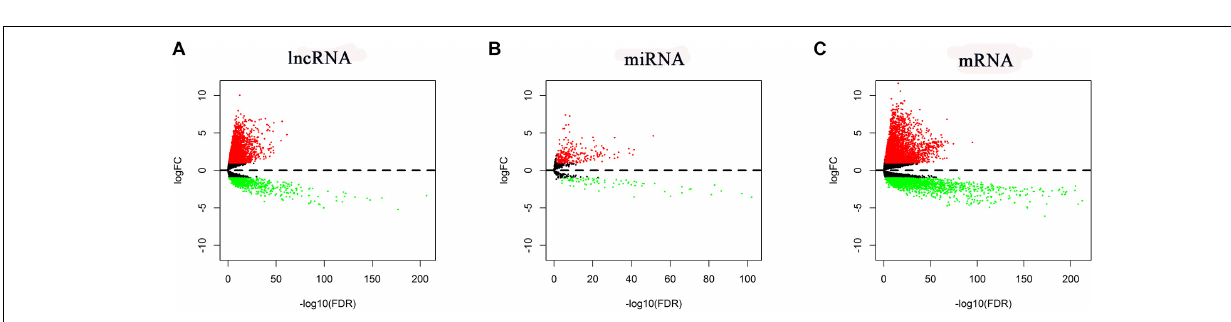
FIGURE 2 | Volcano plots of the DE-lncRNAs, DE-miRNAs, and DE-mRNAs. (A) DE-lncRNAs. (B) DE-miRNAs. (C)